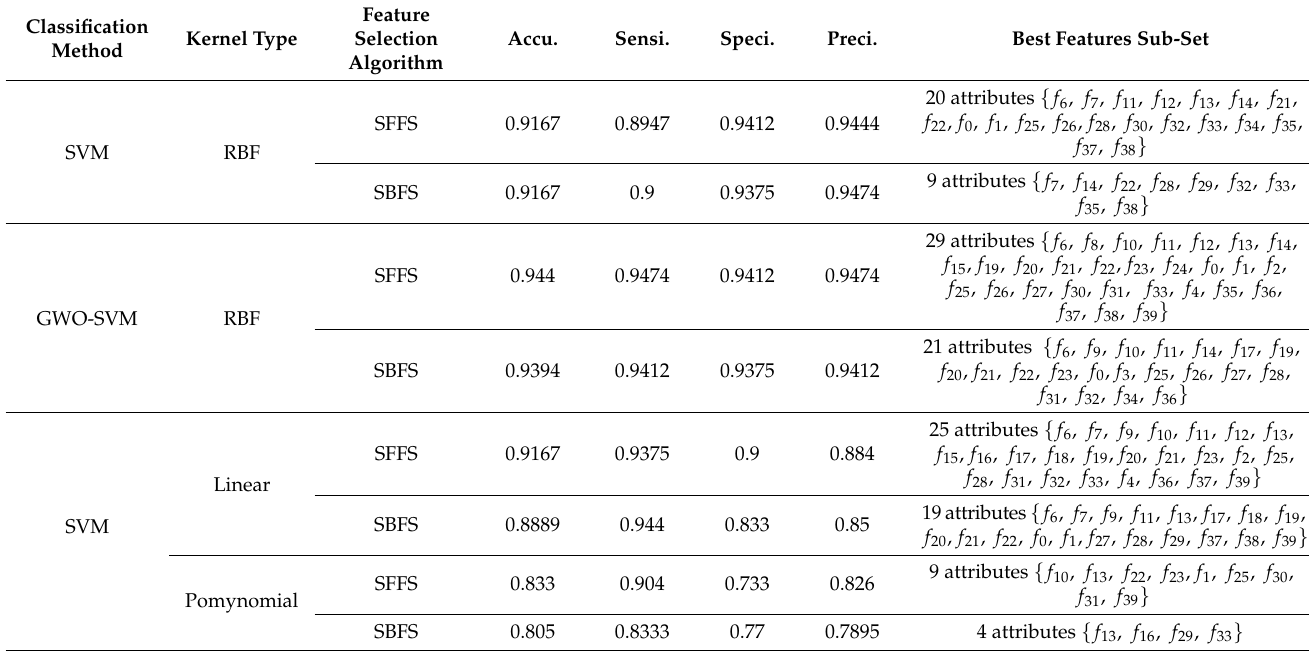
Table 2. Support vector machine classification results using different kernels (the definition of the features can be found in Tables A1 and A2 in the Appendix A).